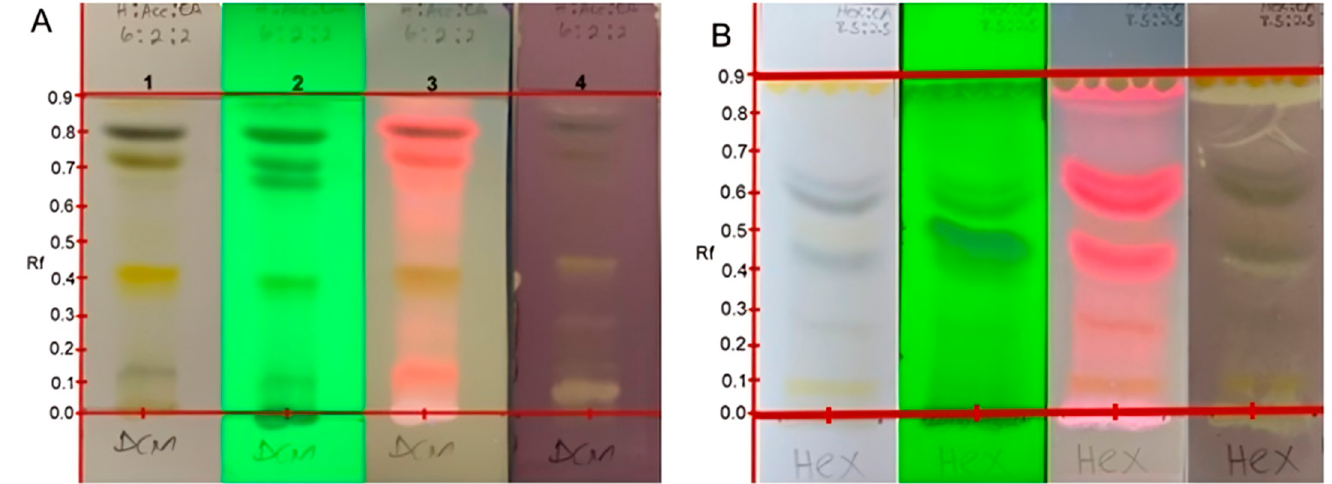
Figure 1. TLC chromatogram of the dichloromethane ( A ) and hexane ( B ) extracts of Mistletoe indicating different phytochemical (plate 1–3) and antioxidant (plate 4) bands. Plates visualized and snapped at white light (1), 255 nm (2), 366 nm (3) and sprayed with 0.2 mM DPPH solution. Table 2. Phytochemical bands and their antioxidant potentials in the non-polar hexane and dichloromethane extracts of Mistletoe tree. Mistletoe Tree Extracts Band